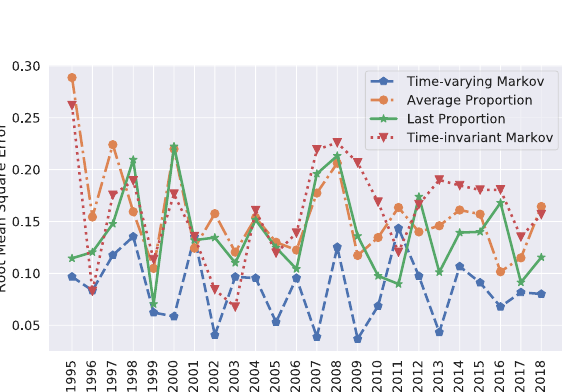
Fig. 7 Model comparison. Root mean-squared error (RMSE) of different baseline algorithms and the proposed time-varying Markov model (dashed blue) in predicting unseen triad proportions in Integrated Crisis Early Warning System (ICEWS) dataset (the smaller RMSE the better). Average Proportion (dash-dotted orange) computes the average of each triad type proportion up to the current time. Last Proportion (solid green) assumes that the new proportion is exactly the last one, and due to the origin of being smooth, it is highly competitive. The proposed Time-invariant Markov (dotted red) chain method minimizes the RMSE, thus providing the most accurate proportion of triads. The results show that the proposed method almost for every year surpassed the baselines ’ accuracy in forecasting the proportion of the